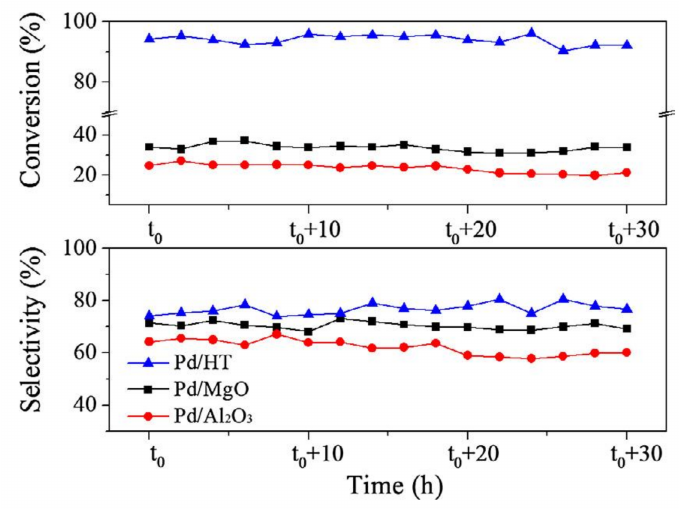
Figure 7. Plots of acetylene conversion and ethylene selectivity for Pd on different supports. (reproduced with permission from [250], Copyright 2015, Elsevier